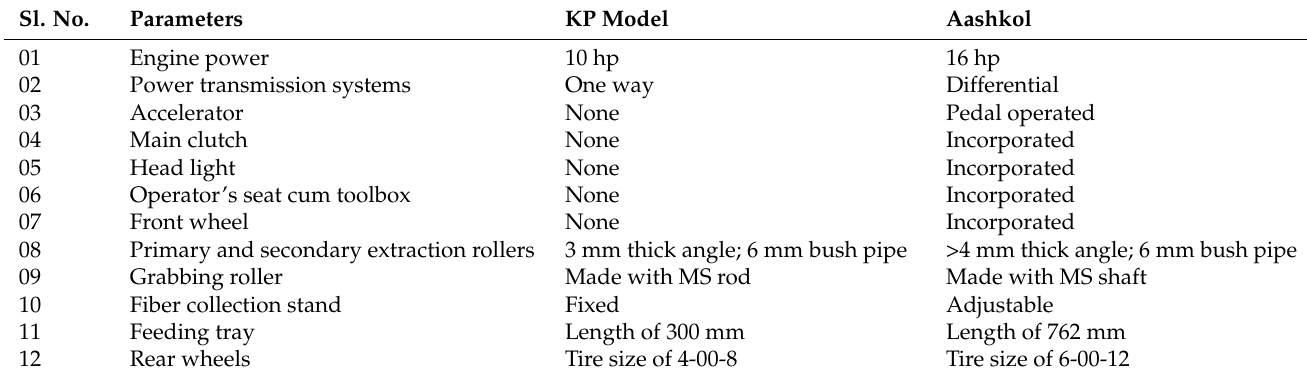
Table 2. Modifications for the Aashkol compared to the KP model .